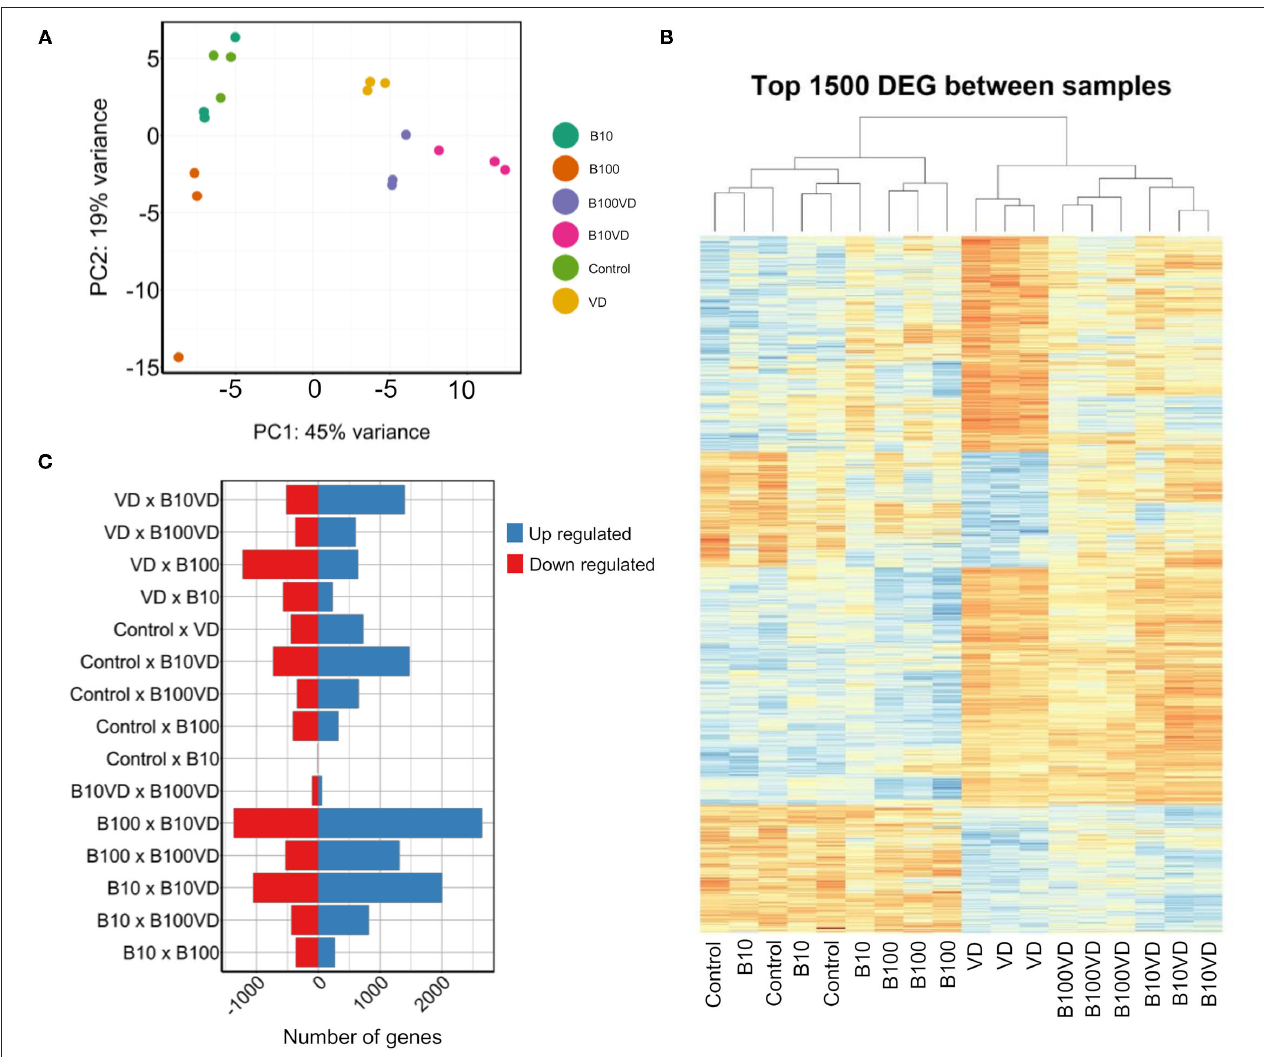
FIGURE 2 | Sample clustering and DEGs across different combinations. (A) PCA of all the samples used in the experiment. (B) Hierarchical clustering of the top 1,500 DEGs across all the samples used in the experiment. (C) Number of upregulated and downregulated genes across different combinations of experimental